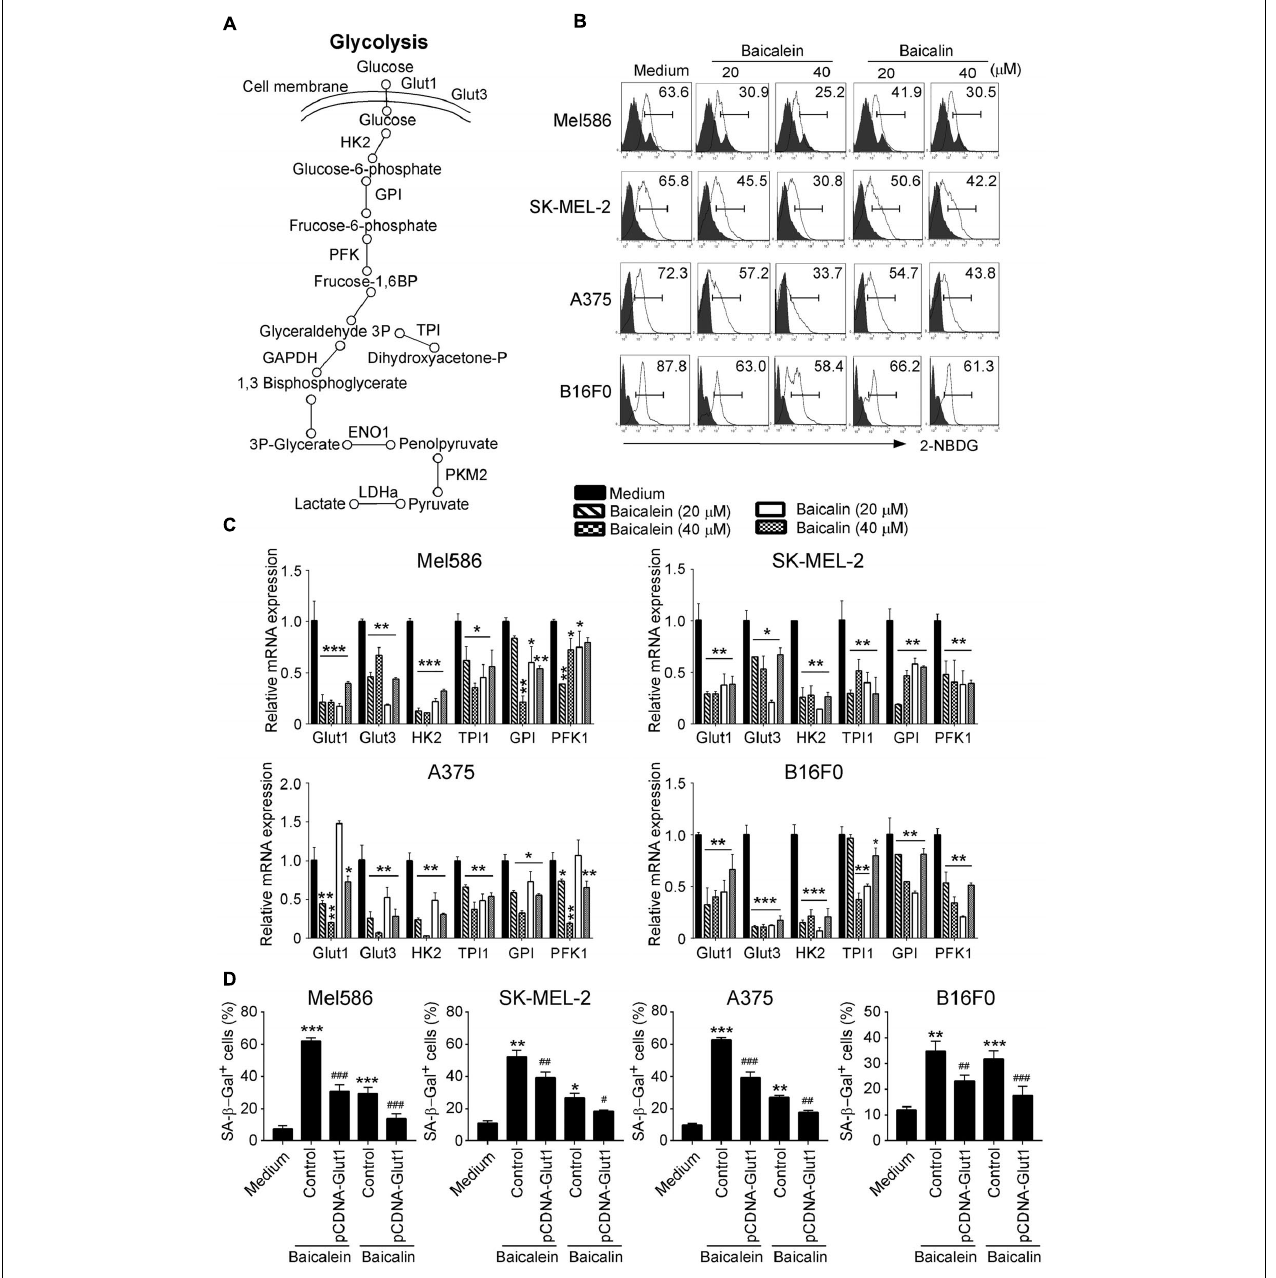
FIGURE 5 | Baicalein and baicalin treatments down-regulate glucose uptake and glycolysis in melanoma cells. (A) The sketch map shows the steps and regulations of the key metabolites and enzymes in cell glycolysis. (B) Baicalein and baicalin treatments significantly decreased glucose uptake in both human and mouse melanoma cells. Glucose uptake of melanoma cells was determined by the flow cytometry with addition of 2-NBDG (100 µ M) for 30 min after 3-day culture with the indicated concentrations of baicalein and baicalin. (C) Baicalein and baicalin treatments significantly down-regulated gene expression levels of key glycolytic enzymes in both human and mouse melanoma cells. Melanoma cells were treated with or without indicated concentrations of baicalein and baicalin for 72 h. Total RNA was isolated from the tumor cells and analyzed by real-time PCR. The expression levels of each gene were normalized to β -actin expression levels and adjusted to the levels in untreated tumor cells (medium). Data shown in different melanoma cells are mean ± SD from three independent experiments. * p < 0.05, ** p < 0.01, and *** p < 0.001, compared with the medium only group. (D) Over-expression of Glut1 prevented cell senescence in melanoma cells induced by baicalein and baicalin. Melanoma cells were transfected with pCDNA-Glut1 or control vector plasmids for 24 h, then cultured for 3 days in the presence of baicalein or baicalin (40 µ M for Mel586, A375, and SK-mel-2 cells, and 50 µ M for B16F0 cells). Senescent cells were analyzed using the SA- β -Gal activity assay. Data shown are mean ± SD from three independent experiments with similar results. * p < 0.05, ** p < 0.01, and *** p < 0.001, compared with the medium control group. # p < 0.05, ## p < 0.01, and ### p < 0.001, compared with the respective baicalein or baicalin treatment group.